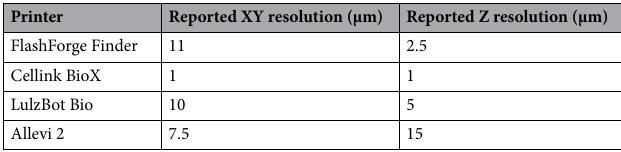
Table 1. Reported resolutions of FlashForge Finder and commercial